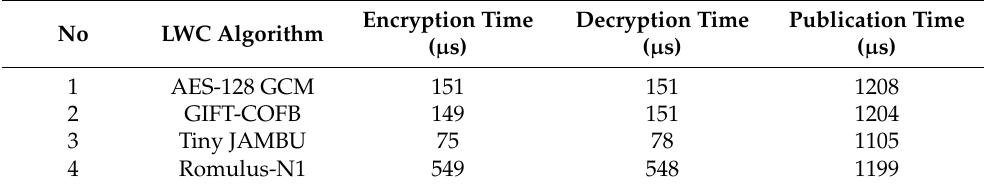
Table 12. Lightweight Cryptographic Encryption and Decryption Performance on STM32L4 with 10 Characters Messages Used Registered Account.